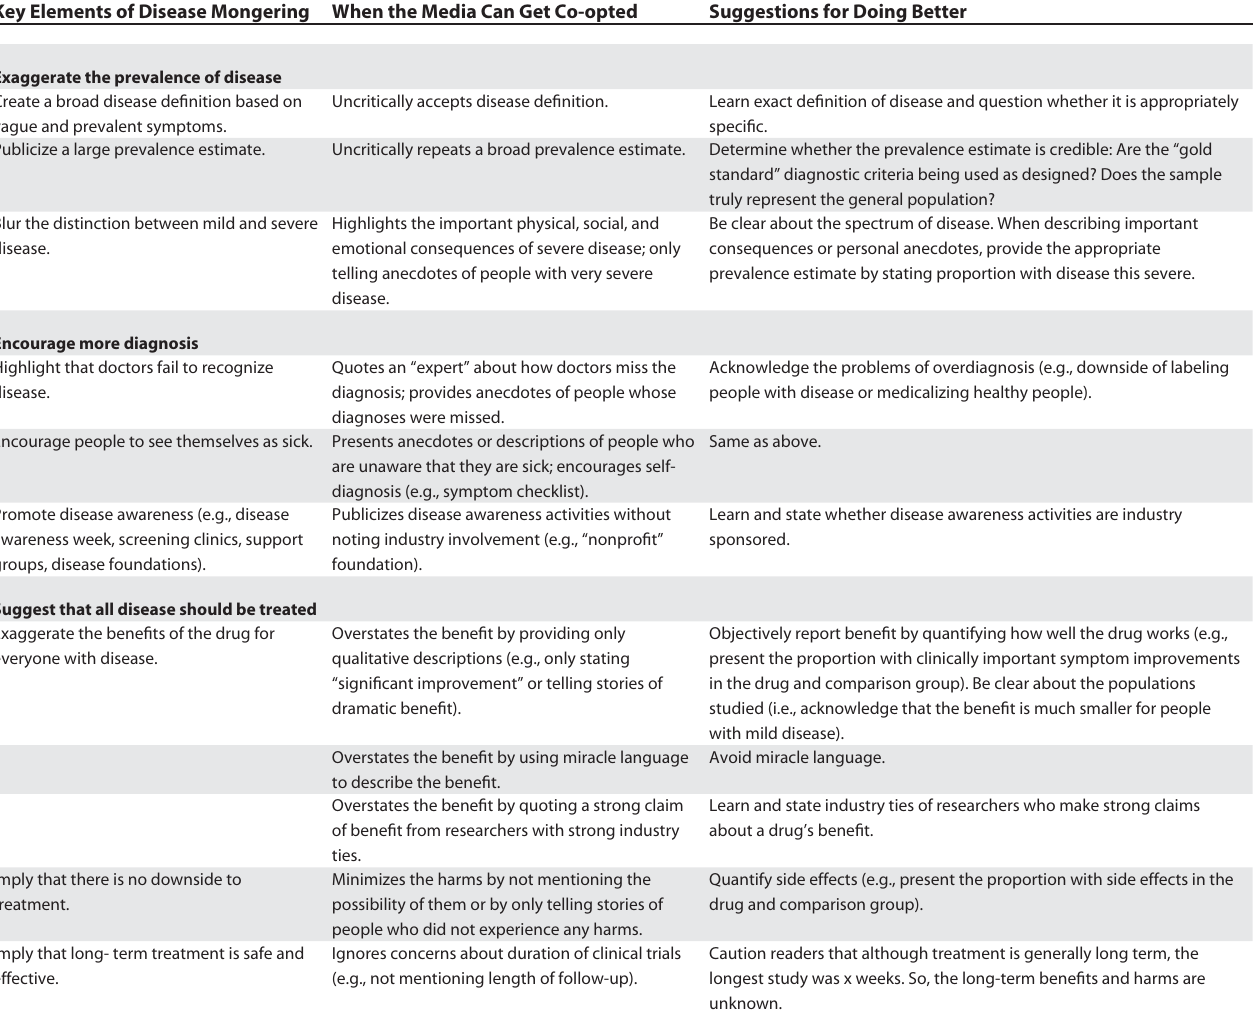
Table 1. Key Elements of Disease Mongering and How the Media Could Do Better Key Elements of Disease Mongering When the Media Can Get Co-opted Suggestions for Doing Better Exaggerate the prevalence of disease Create a broad disease defi nition based on vague and prevalent